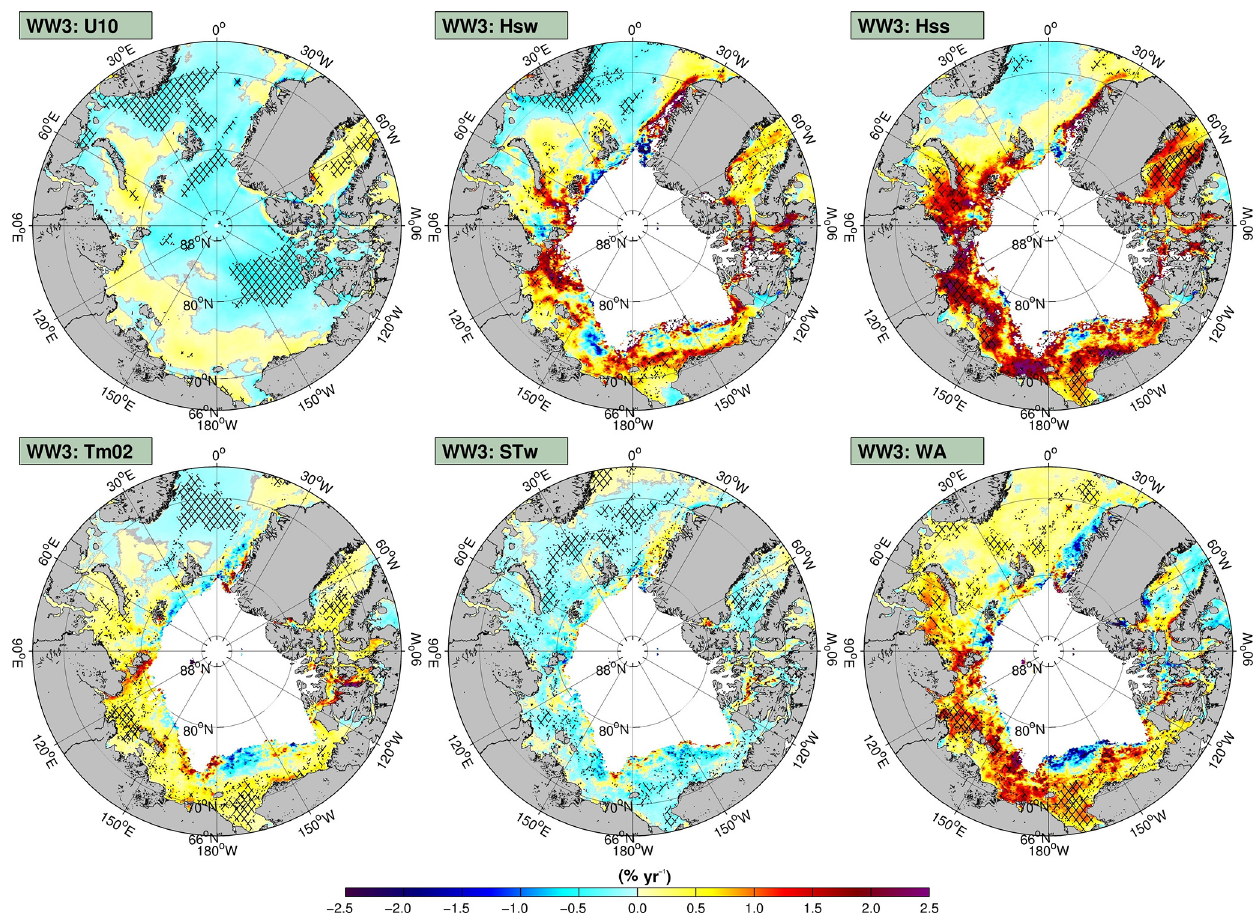
Figure 8. Sen’s slope with the Mann–Kendall test (thatched areas) for monthly averaged wind speeds (U10) (top left), wind-sea wave heights ( H sw ) (top center), swell wave heights ( H ss ) (top right), average wave period ( T m 02) (bottom left), wind-sea steepness (ST w ) (bottom center), and wave age (WA) (bottom right) from the wave hindcast in percentage per year relative to the average.